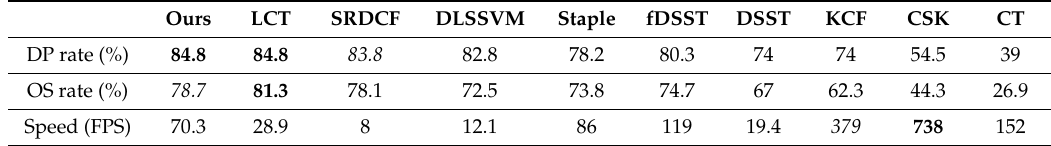
Table 1. The performance on OTB2013 dataset of nine trackers.